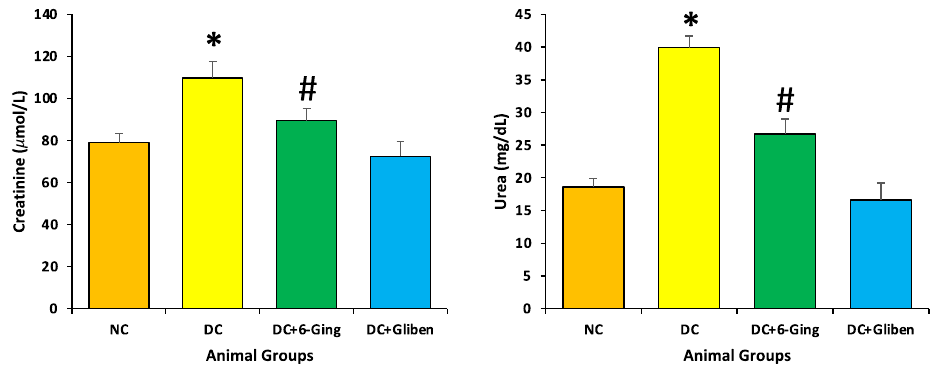
Figure 3. The kidney function test profile (creatinine and urea) in different groups of rats after 8 weeks of treatment. The rats were equally divided into 4 groups, each group ( n = 8). Data are presented as mean ± standard error of the mean (SEM). Groups: Normal control (NC); disease control (DC), i.e., STZ-treated group; treatment group (DC + 6-gingerol); positive control (PC) animal treated with STZ + glibenclamide; * p < 0.05 (significant difference of final b.w. between DC vs. NC) # p < 0.05 (significant difference of final b.w. between DC vs. DC+6-gingerol).